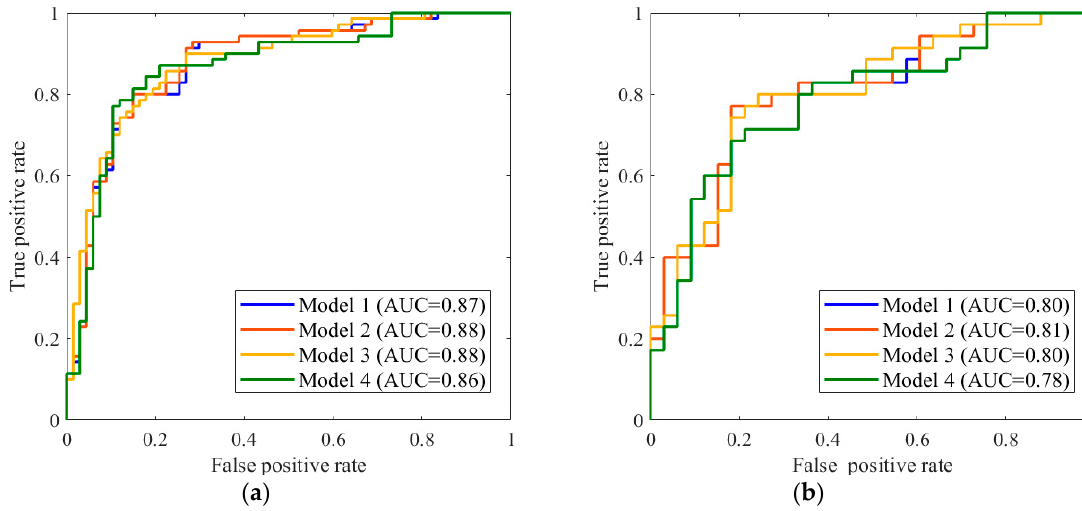
Figure 4. ROC of four models in training ( left ) and testing ( right ). (Model 1: LSSVM + LN, model 2: LSSVM + RBF, model 3: LSSVM + PL, model 4: LR). ( a ) training ( b ) testing.